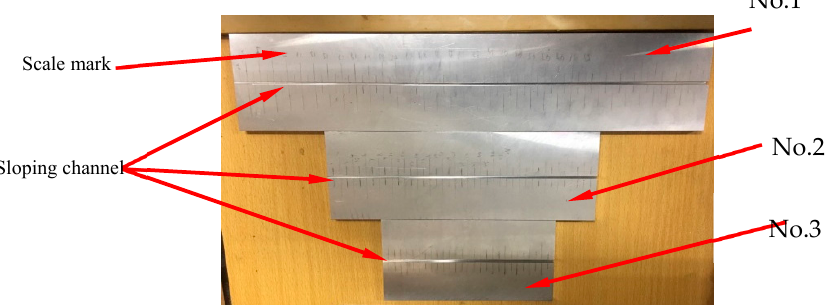
Figure 12. Aluminum plate with sloping channel.